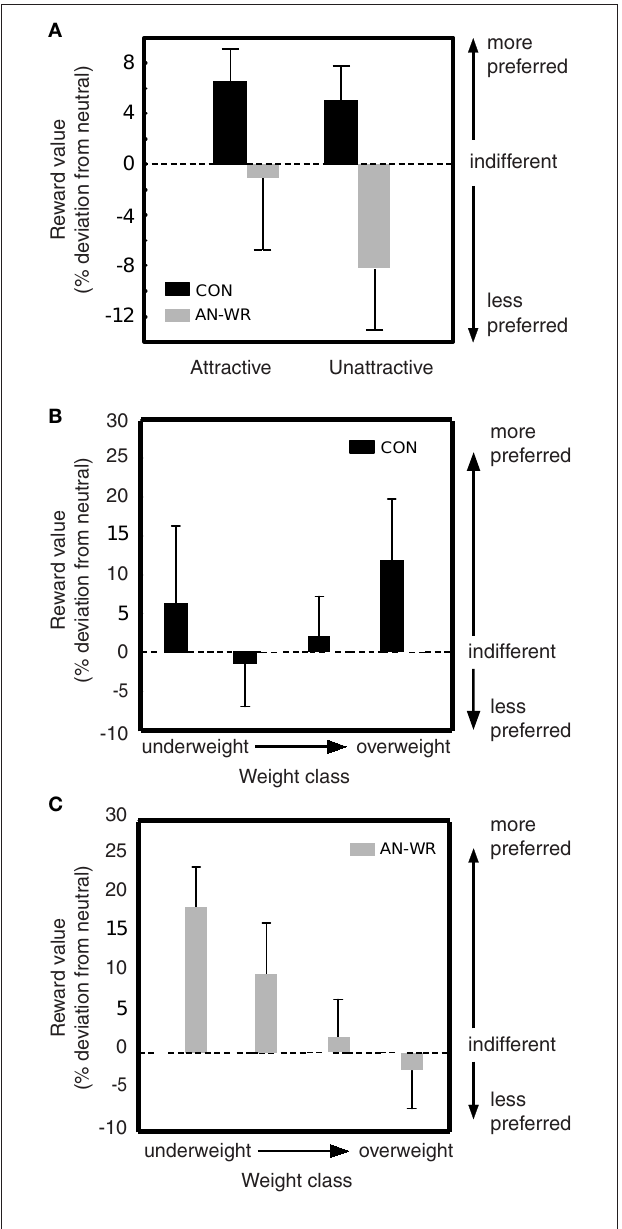
Figure 2 | Disruptions in social reward value in anorexia nervosa. (A) In an econometric choice task, control participants (CON, black) paid significantly more than participants with anorexia nervosa (AN-WR, gray) to view both attractive and unattractive face images. (B) When given the opportunity to view full body images in the context of the econometric choice task, control participants were indifferent to the weight of the depicted individual. (C) In contrast, the amount participants with anorexia nervosa paid to display full body images scaled with the weight of the depicted